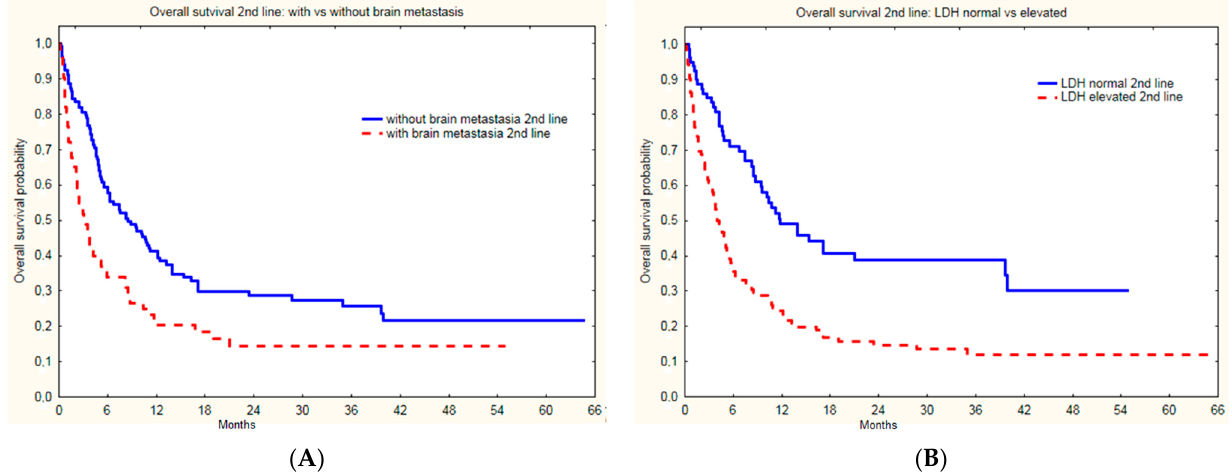
Table 4. Factors that influence OS in metastatic melanoma patients treated with BRAFi/MEKi -> immunotherapy—treatment sequence.